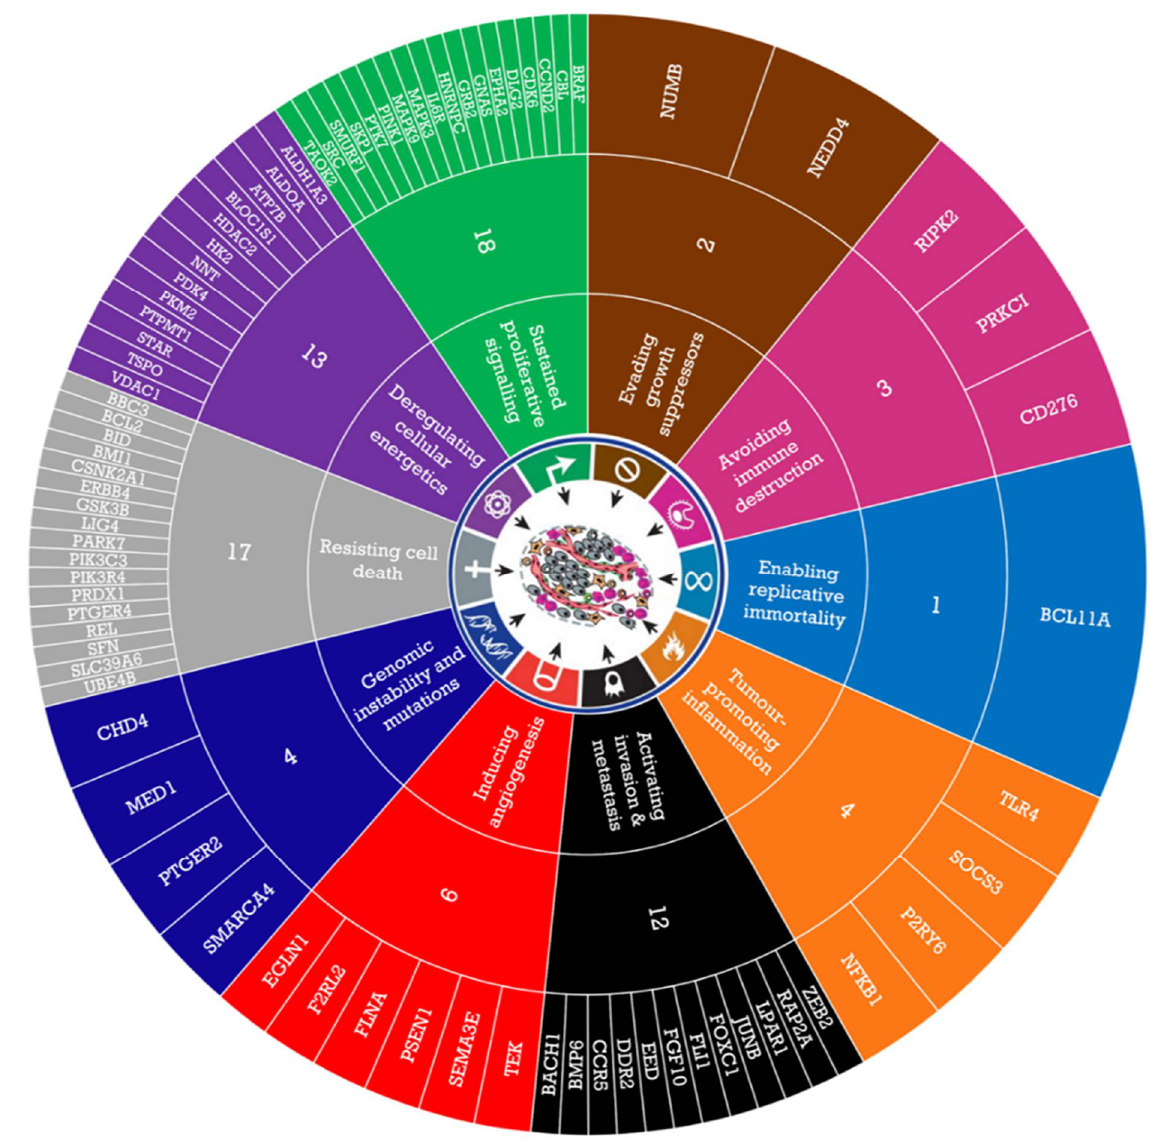
Figure 1. Candidate genes for siRNA screen. A total of 80 out of 784 enriched genes identified by GSEA were chosen for further evaluation based on the criteria (1) biological relevance to OAC, (2) expression in oesophageal/gastric tissue, (3) interacting genes and networks, and (4) targetability, and these can be further classified by Hanahan and Weinberg’s Hallmarks of